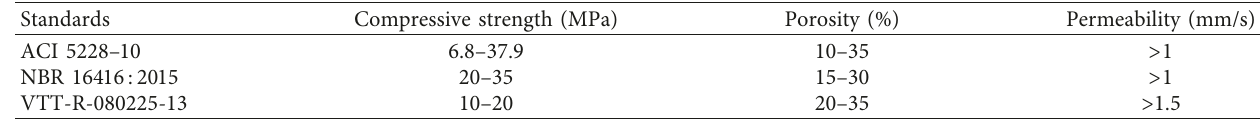
Table 4: Compressive strength, porosity, and permeability from standards.